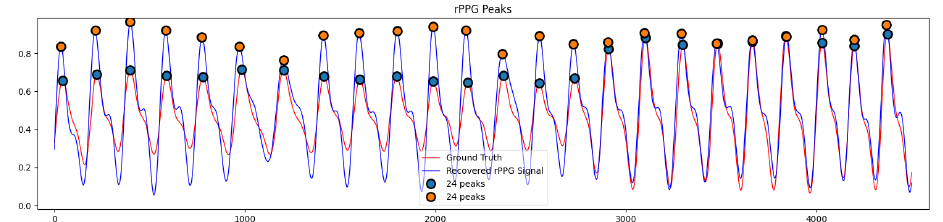
Figure 13. Comparison of peak detection between recovered rPPG signal and ground truth PPG